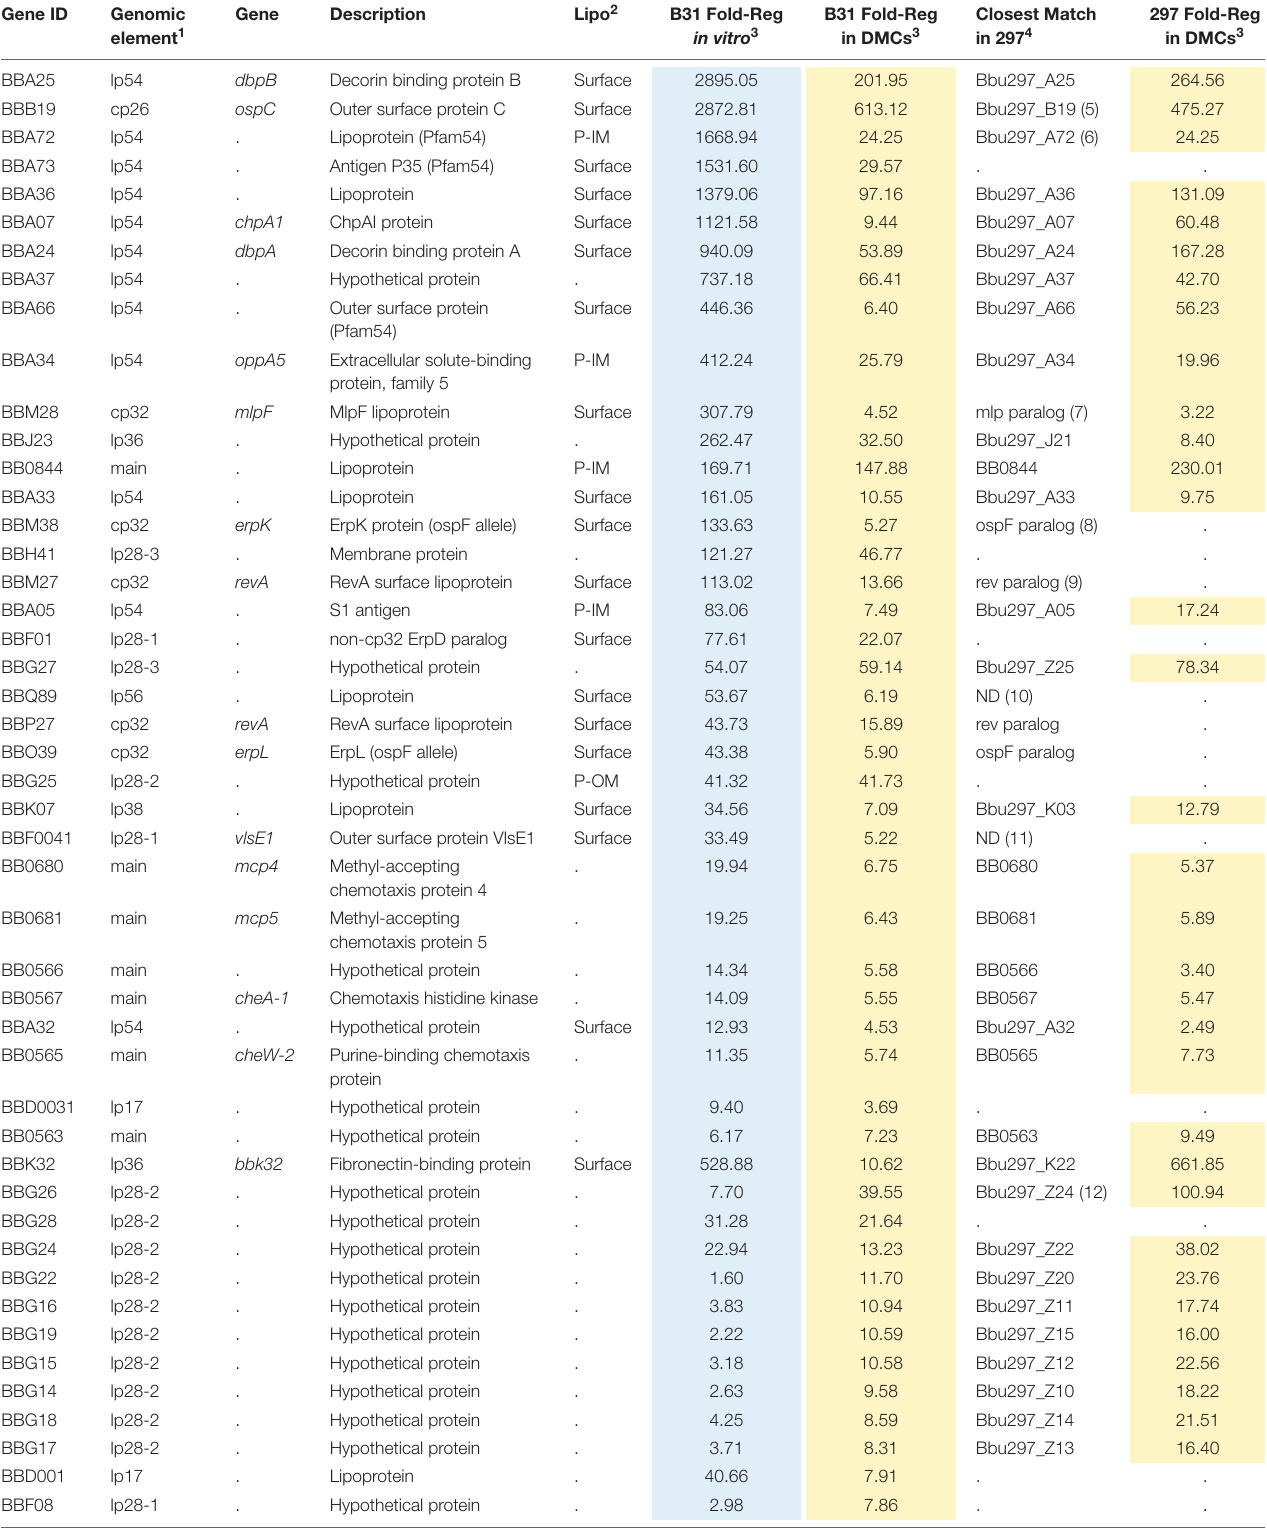
TABLE 2 | Genes upregulated by RpoS in Borrelia burgdorferi in vitro and within